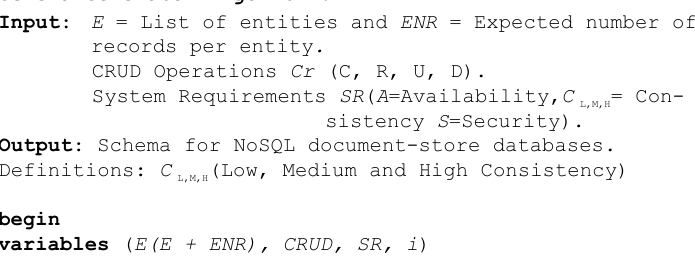
Schema generator